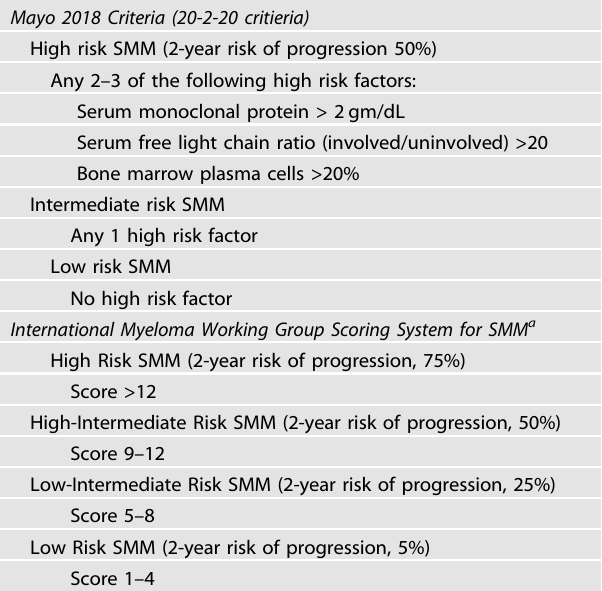
Table 2. Risk strati fi cation of smoldering multiple myeloma